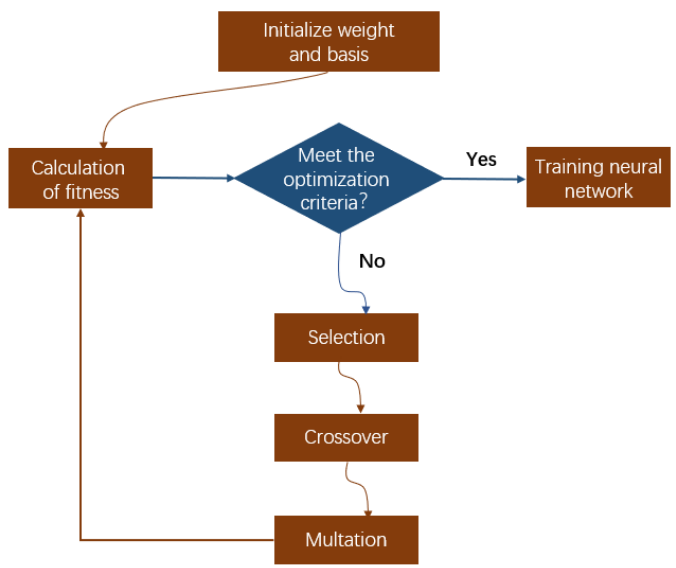
Figure 17. GA for optimizing the network’s weights and biases.